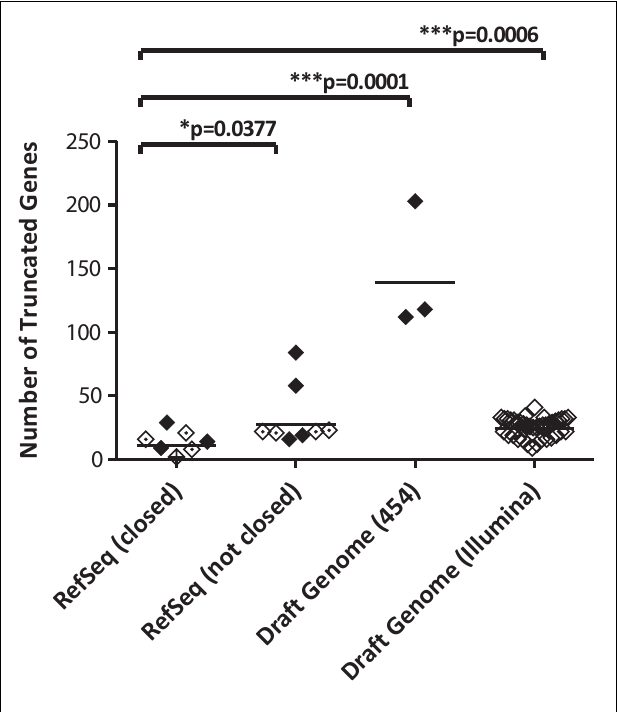
FIGURE 1 | Finishing quality is reflected in the number of truncated predicted genes in C. jejuni whole genome sequences. The C. jejuni genomes used in this analysis were classified according to finishing levels (reference sequence or draft), and/or sequencing platform used [Sanger open diamonds with a central period), 454 (closed diamonds), or Illumina (open diamonds)].The number of predicted genes with truncations relative to C. jejuni NCTC11168 was calculated for each genome.The mean number of truncations for each group is represented by a line. Closed genomes had significantly fewer truncations than RefSeq genomes that were not closed and draft genomes generated with either 454 or Illumina sequencing